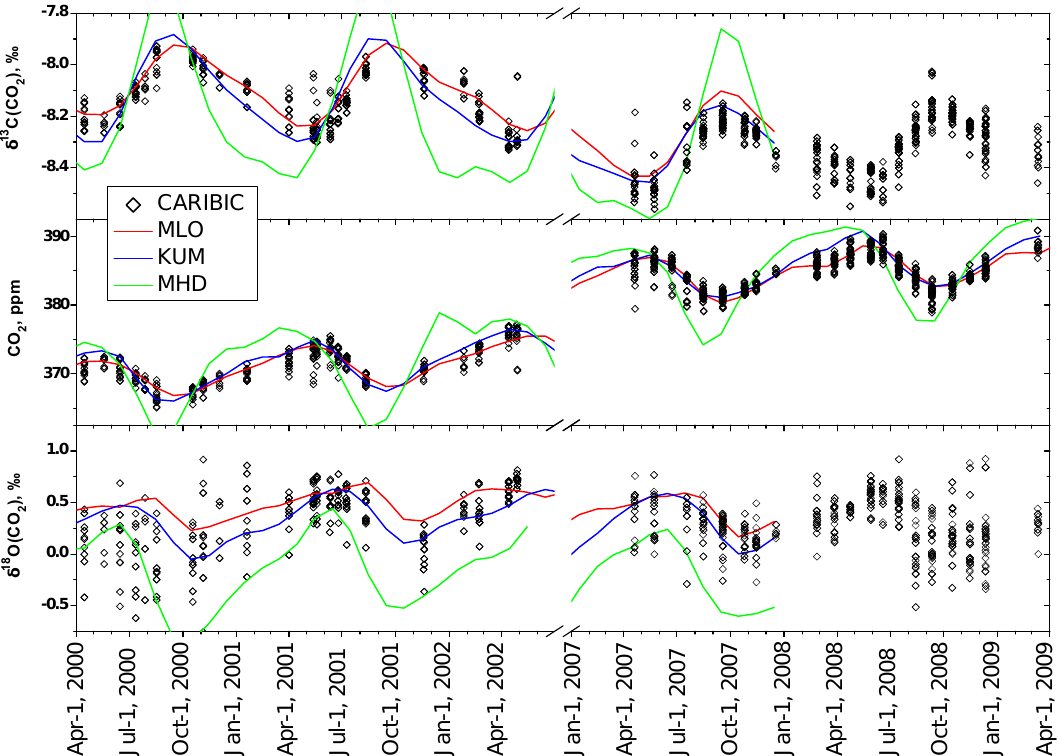
Fig. 9. CO 2 , δ 13 C(CO 2 ) and δ 18 O(CO 2 ) data of CARIBIC-1 and CARIBIC-2 (only tropospheric samples, lat. > 14 ◦ N) as time series together with data for the stations (MLO, KUM, IZO and MHD, White and Vaughn, 2009). (At the moment of revision, June 2010, NOAA has not released isotope data for